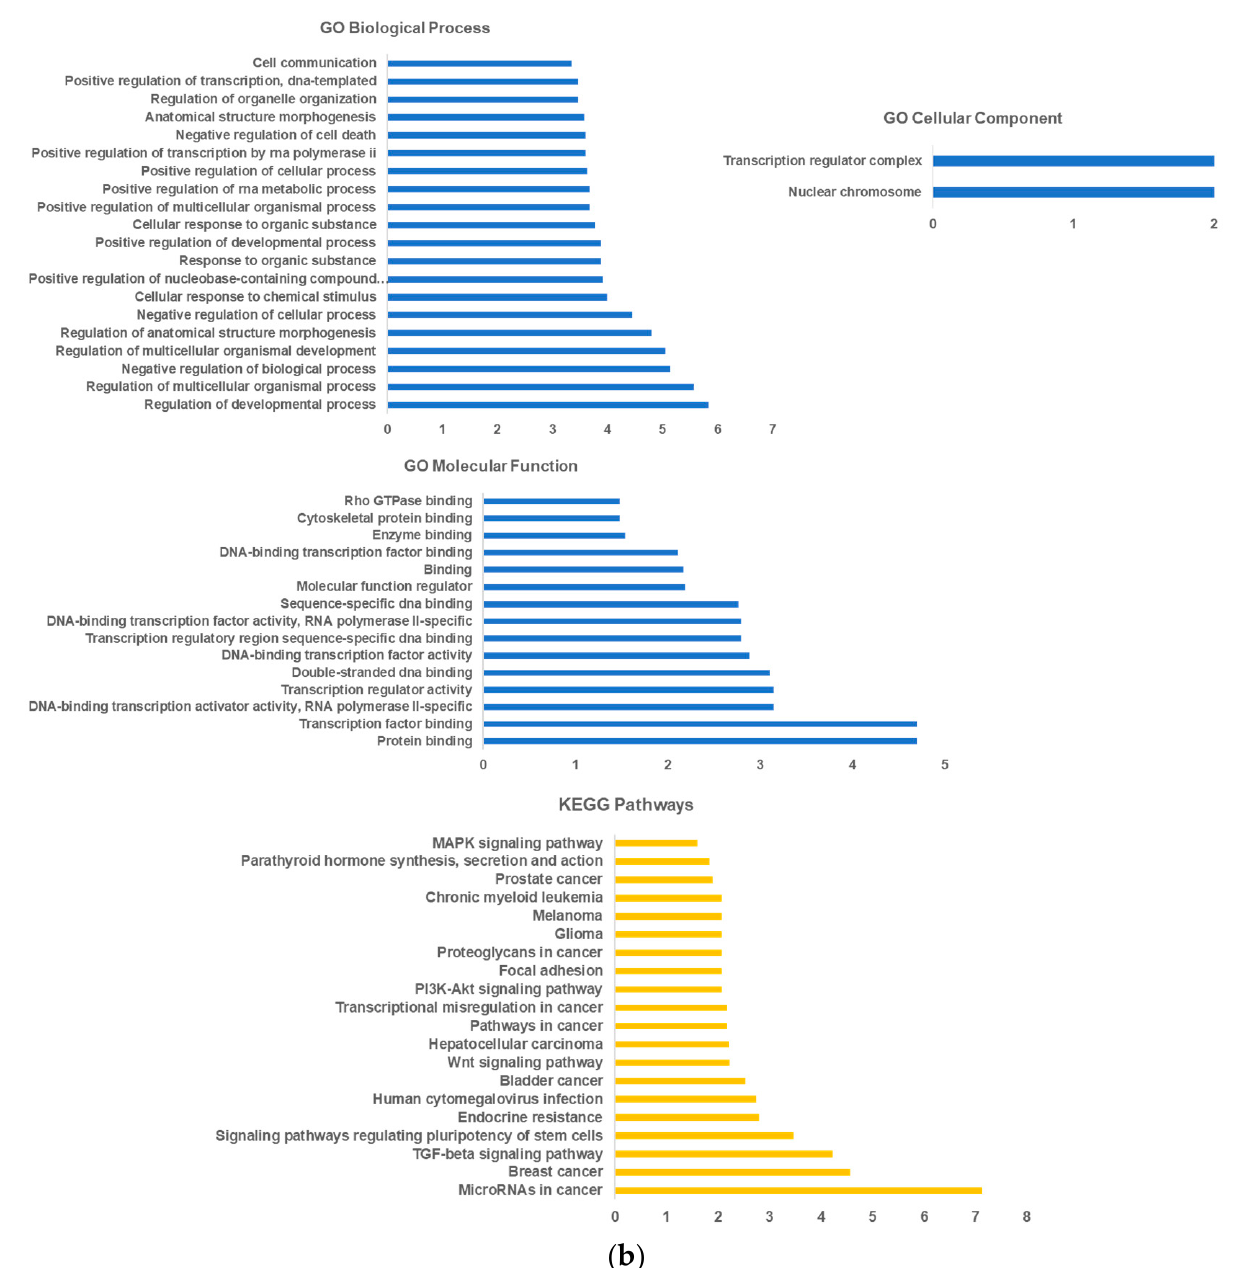
Figure 4. Enrichment analysis for hsa-miR-150-5p ( a ) and hsa-miR-335-5p targets ( b ).